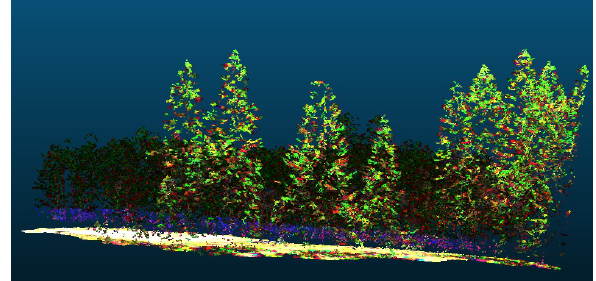
Figure 3. Visualization of an example forest area with deciduous and coniferous tree species in the MLS point clouds. Deciduous and coniferous tree species based on their intensity values are represented with different